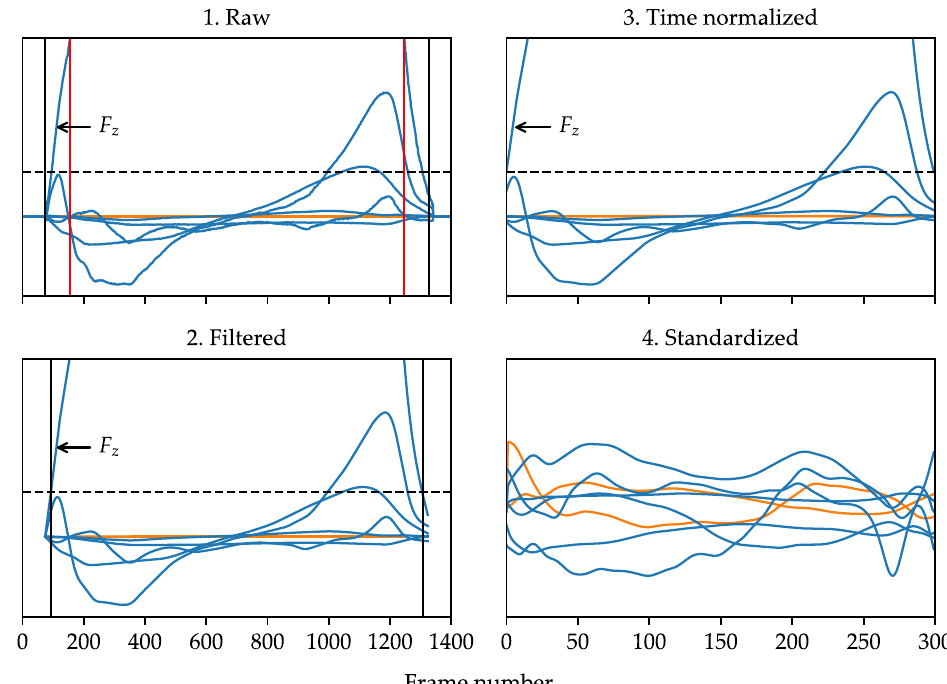
Figure 4. Illustration of the signal pre-processing method for ground reaction forces (GRFs) and ground reaction moments (GRMs) (blue) compared to center of pressure (COP) coordinates (orange). Vertical black lines indicate clip points for GRFs and GRMs. Vertical red lines indicate clip points for COP coordinates. The horizontal dashed line is at 50N magnitude. The Y-axis limits excluded most of F z so that other components were easier to